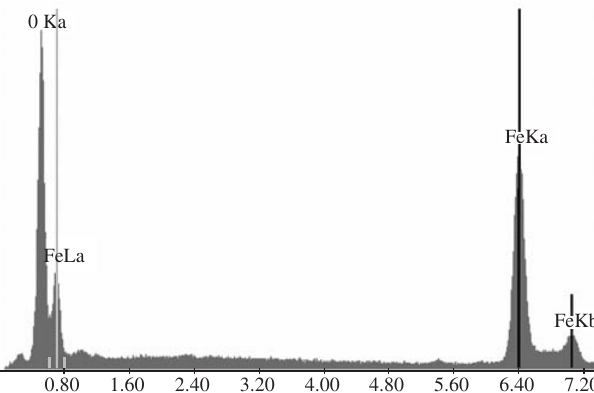
Figura 11. Chemical composition of the region indicated in Figure 10, ob- tained by EDX analysis.